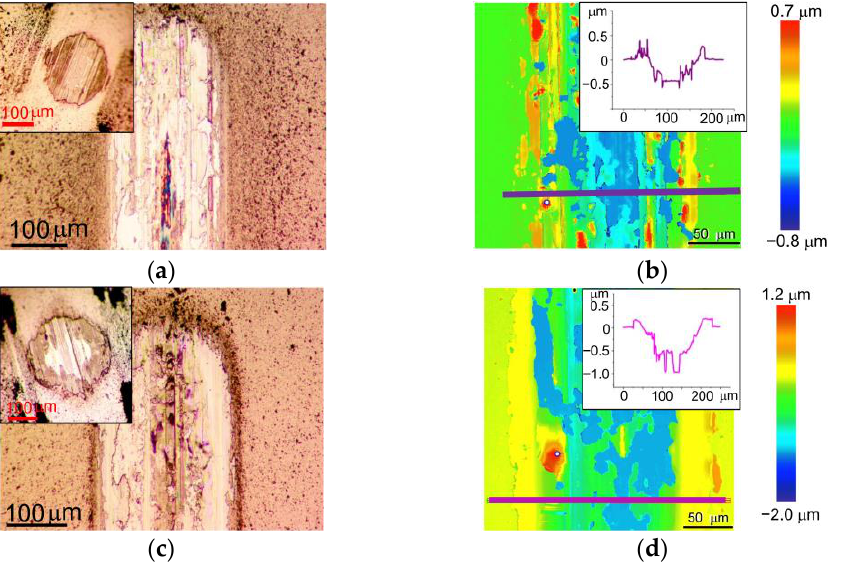
Figure 8. Wear of the ( a , b ) WSe x /NP-W and ( c , d ) WSe x S y /NP-W_3.6 coatings after tribotest in air at a load of 1 N: inserts in ( a , c ) show the wear scars of counter bodies (balls), and the depth profile of the wear tracks are shown in the inserts in ( b , d ).